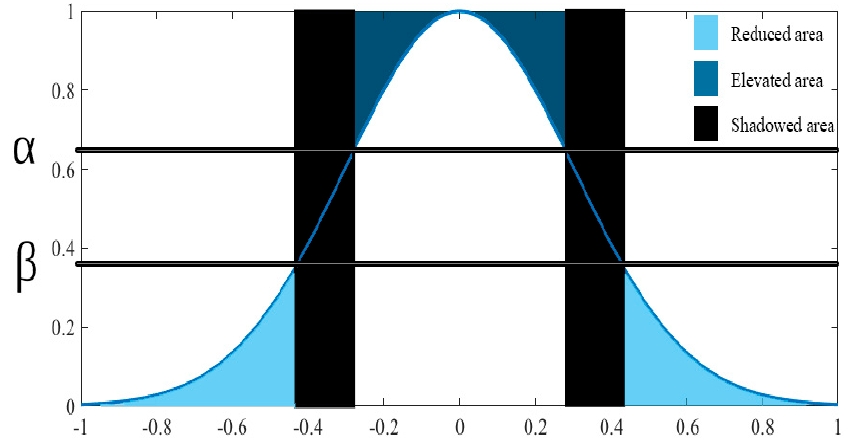
Figure 1. Graphical representation of a shadowed set.